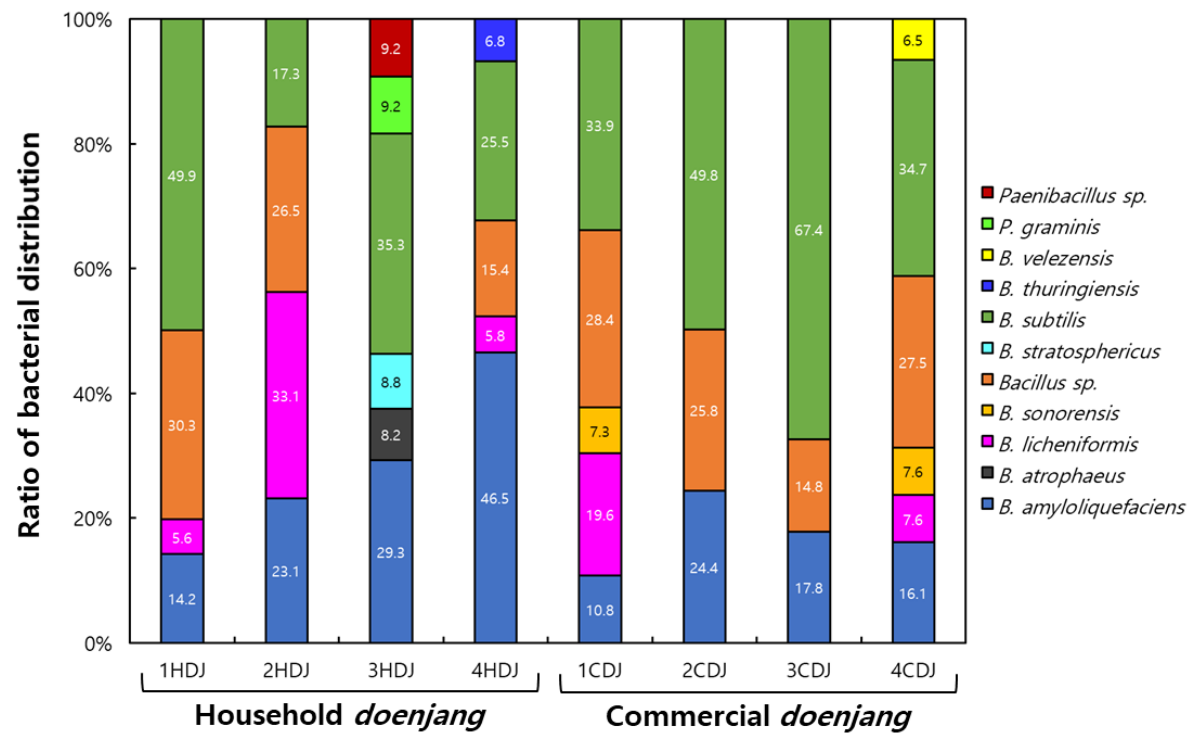
Figure 2. Comparisons of the bacterial distribution of isolates from household and commercial doenjang .